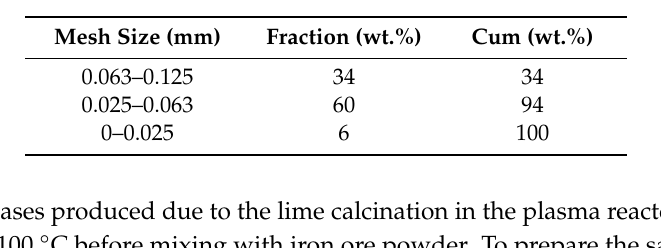
Table 4. Grain size distribution of Carajas iron ore and